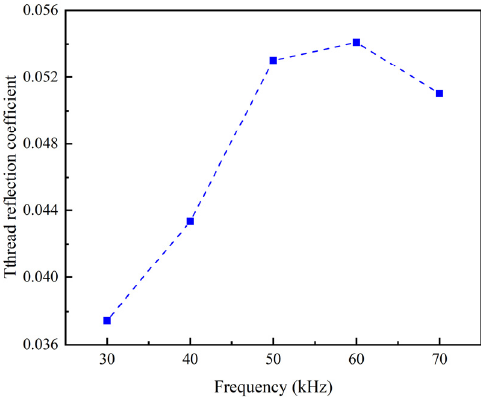
Figure 9. Thread reflection coefficients at different excitation frequencies.